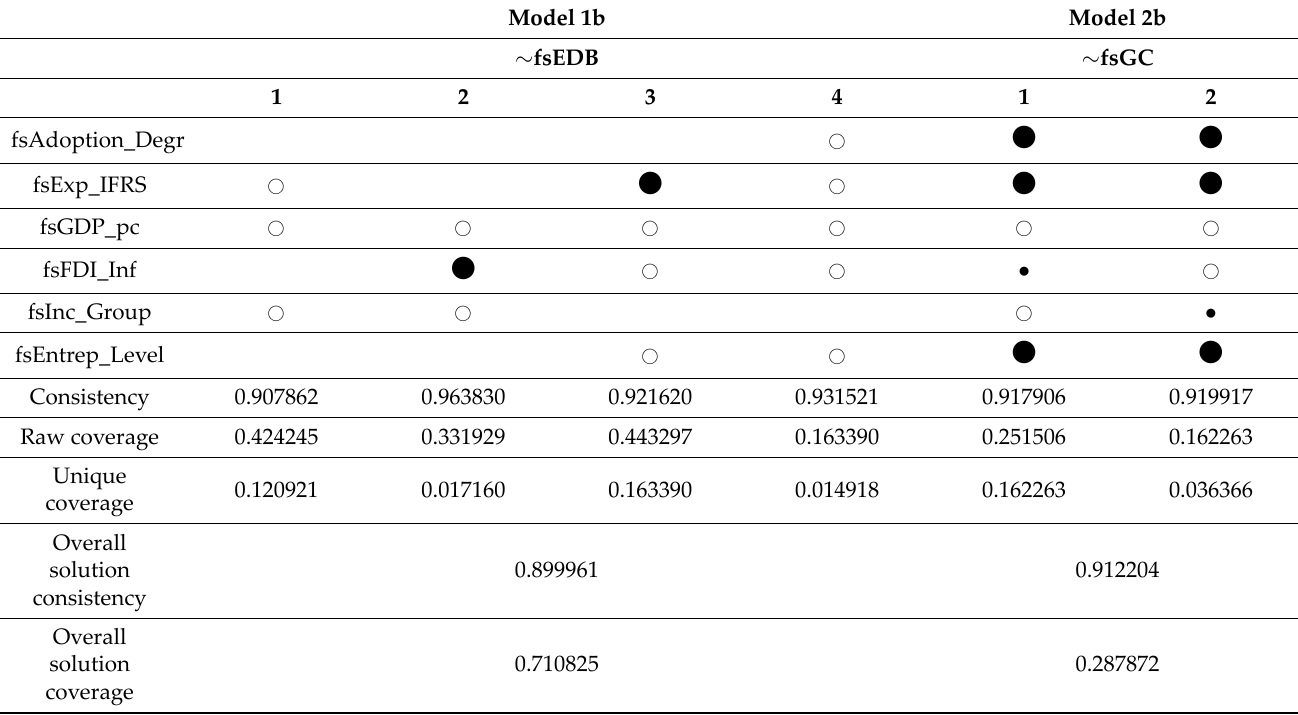
Table 8. Solution from fsQCA: configurations for achieving high GC scores — Model 2a .